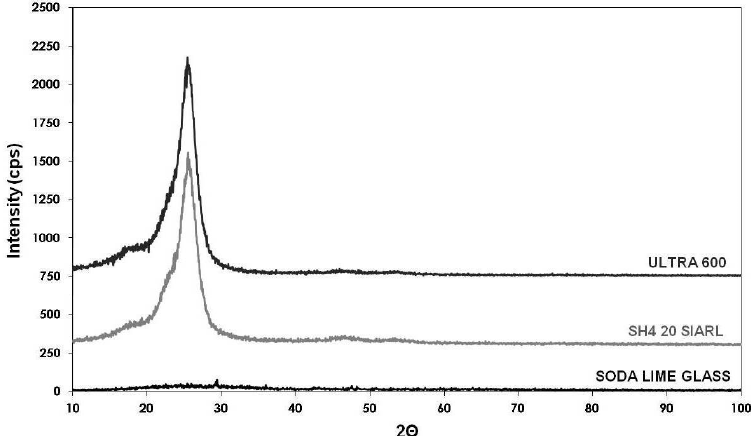
Figure 1. X ‐ ray diffraction (XRD) pattern of multilayered polymer ‐ based coatings on glass and bare Figure 1. X-ray diffraction (XRD) pattern of multilayered polymer-based coatings on glass and bare soda ‐ lime glass. soda-lime